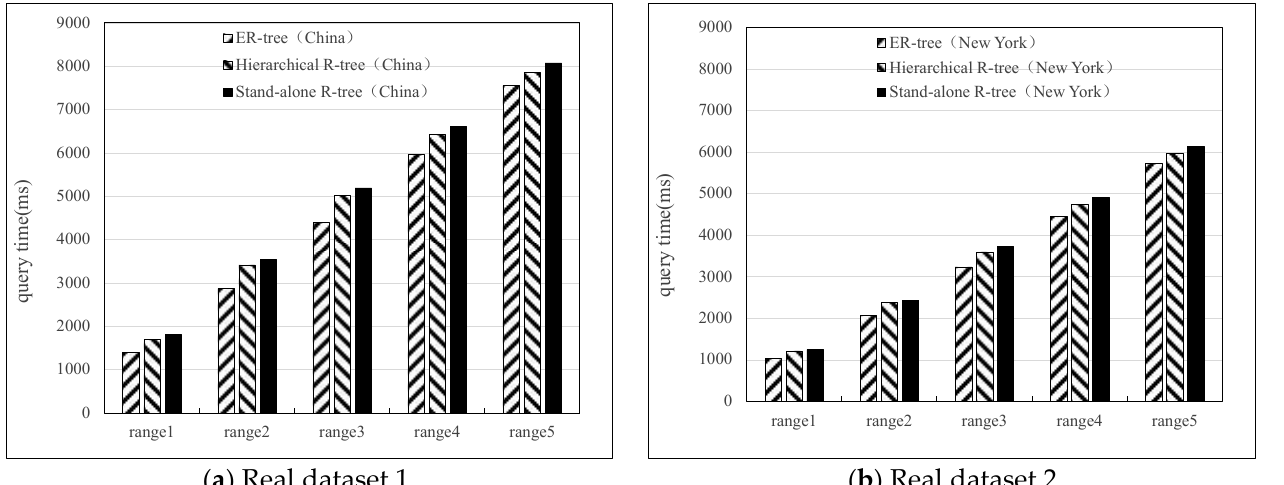
Figure 16. Comparison of the index range query performance on the real dataset. Real dataset circle query: Using the centre point of the real dataset to gradually expand the circle range outward, this paper conducted five circle query operations on the Chinese and New York datasets, respectively, and the last query covered all the data points of the real dataset. The experimental results are shown in Figure 17. Similar to the range queries, the ER-tree indexes have better query performance for both short and large circular ranges. It is worth noting that circular range queries can be used for KNN queries that are common in spatial queries.